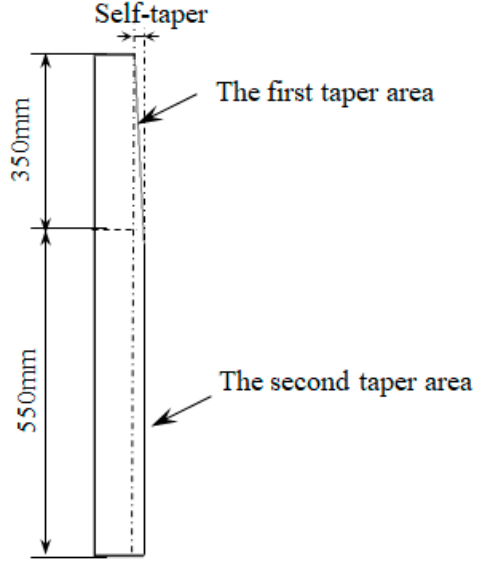
Figure 8. The schematic diagram of double taper mold.